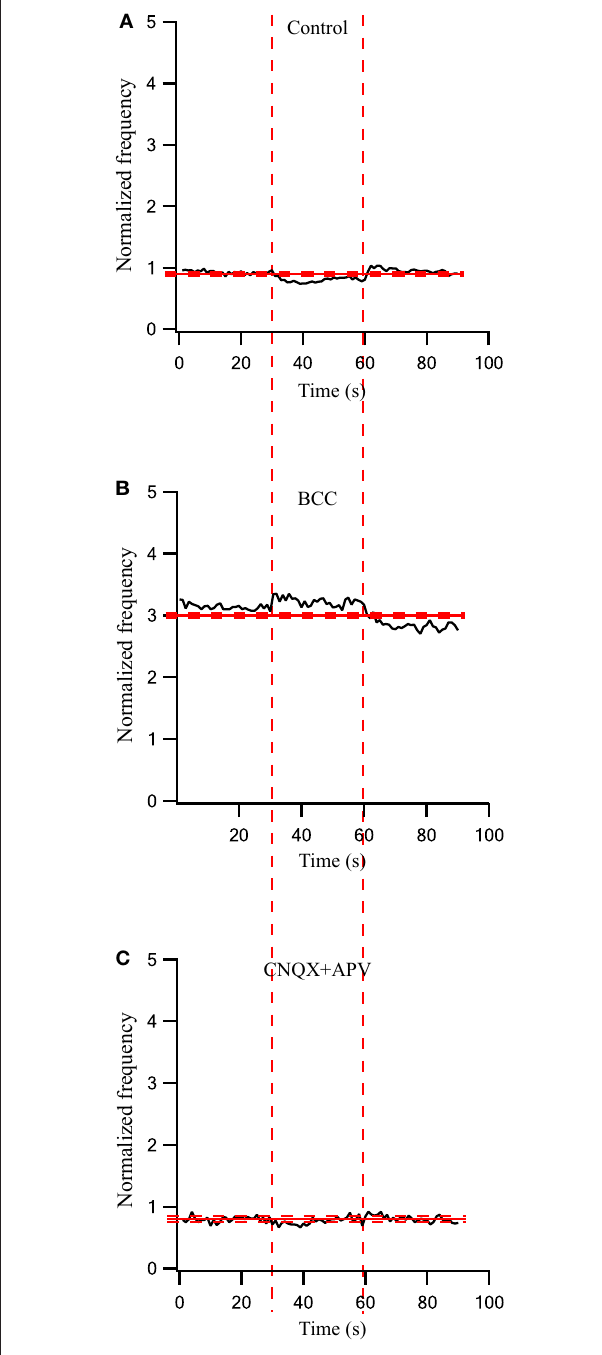
Figure 3 | Firing rate changes during stimulation at 10 Hz before and after application of gABAergic and glutamatergic antagonists. (A) Population firing rate of GP neurons in normal extracellular solution ( n = 41). (B) Population frequency of GP neurons after applying 50 μM bicuculline to the extracellular solution ( n = 17). (C) Population frequency of GP neurons after applying 15 μM CNQX and 50 μM APV to the extracellular solution ( n = 14). The thick and dashed horizontal lines indicate the average and SD of the pre-stimulus frequency, respectively. The dashed vertical lines mark the beginning and the end of the stimulus.